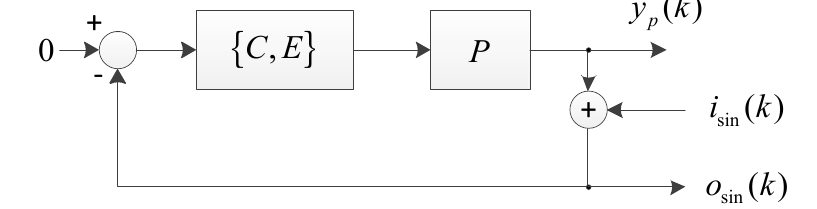
Figure 8. Measurement method of frequency responses.